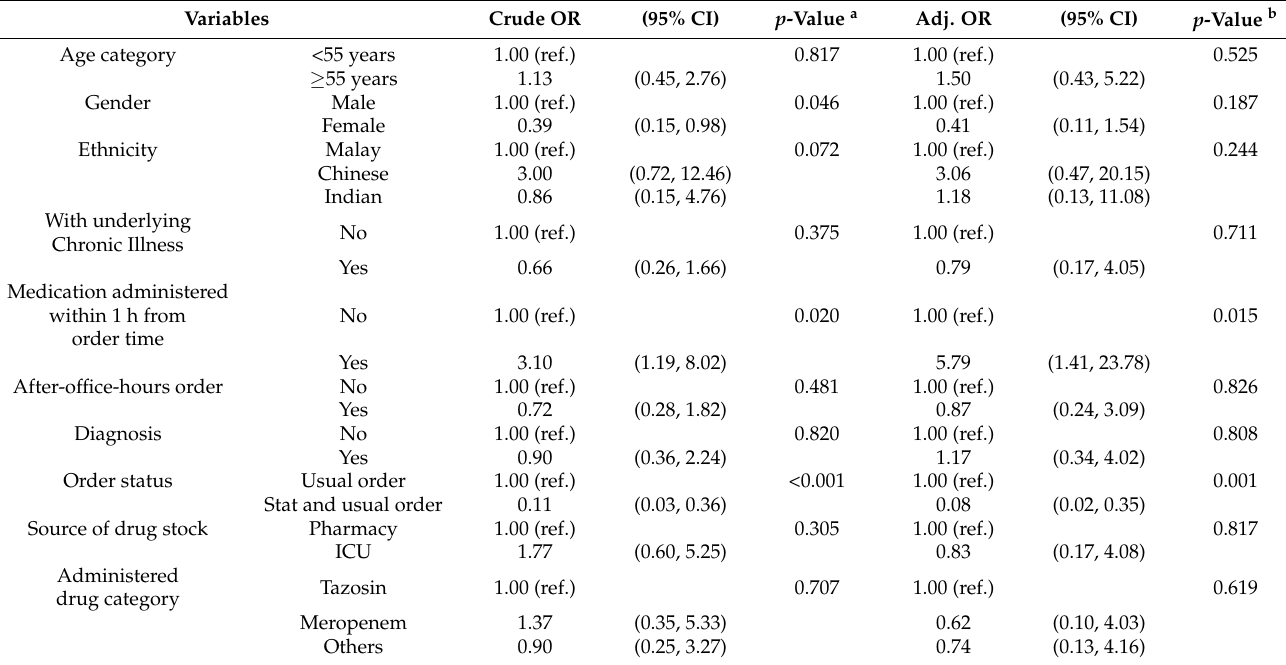
Table 3. Multiple logistic regression on various